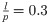
Which improvements reduce the risk of intrusion?For each utility (grey dot) in our filtered IBNET and BWBWUI database, we plot the predicted log reduction (LR) of intruded volume in steady-state (a & b) and flushing (c & d) phases, attributable to increasing the supply duration to 23.75 hrs/day (thick black line) and attributable to the necessitated EOA reductions. For steady-state (a & b), the effects are considered together (solid thin lines), but for the flushing phase (c & d), the effect of EOA reduction is shown separately (dashed thin lines). We plot each utility under scenarios i) and ii) (i.e., lp=0.3 (a & c) and lp=0.02 (b & d)). For initial supply durations within a one-hour span (e.g., 4.5-5.5 hrs/day), the 5th (red/upper line), 50th (i.e., median, green/middle line), and 95th (blue/lower line) percentiles are smoothed into the displayed curves.